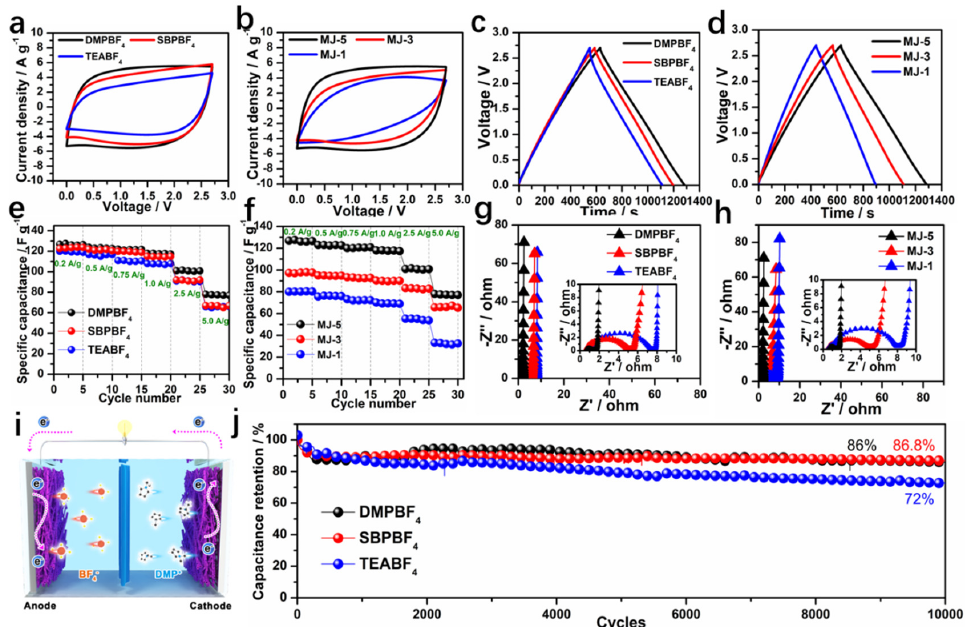
Figure 6. Electrochemical performance of MJ − x in organic electrolyte. ( a ) CV curves of MJ − 5 using different electrolytes at 10 mV s − 1 ; ( b ) CV curves of MJ − x using DMPBF 4 ; ( c ) Specific capacitance of MJ − 5 using different electrolytes at 0.2 A g − 1 ; ( d ) GCD curves of MJ − x using DMPBF 4 at 0.2 A g − 1 ; ( e ) Rate performance of MJ − 5 at different electrolyte; ( f ) Rate performance of MJ − x at DMPBF 4 ; ( g ) Nyquist plots of MJ − 5 using different electrolytes; ( h ) Nyquist plots of MJ − x using DMPBF 4 ; ( i ) Schematic of a supercapacitor device; ( j ) Cycling performance of MJ − 5 in different electrolytes.